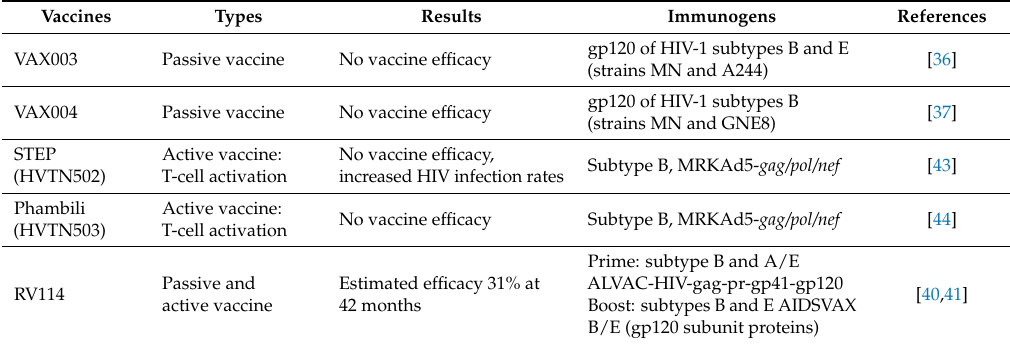
Table 1. Human immunodeficiency virus type 1 (HIV-1) vaccine